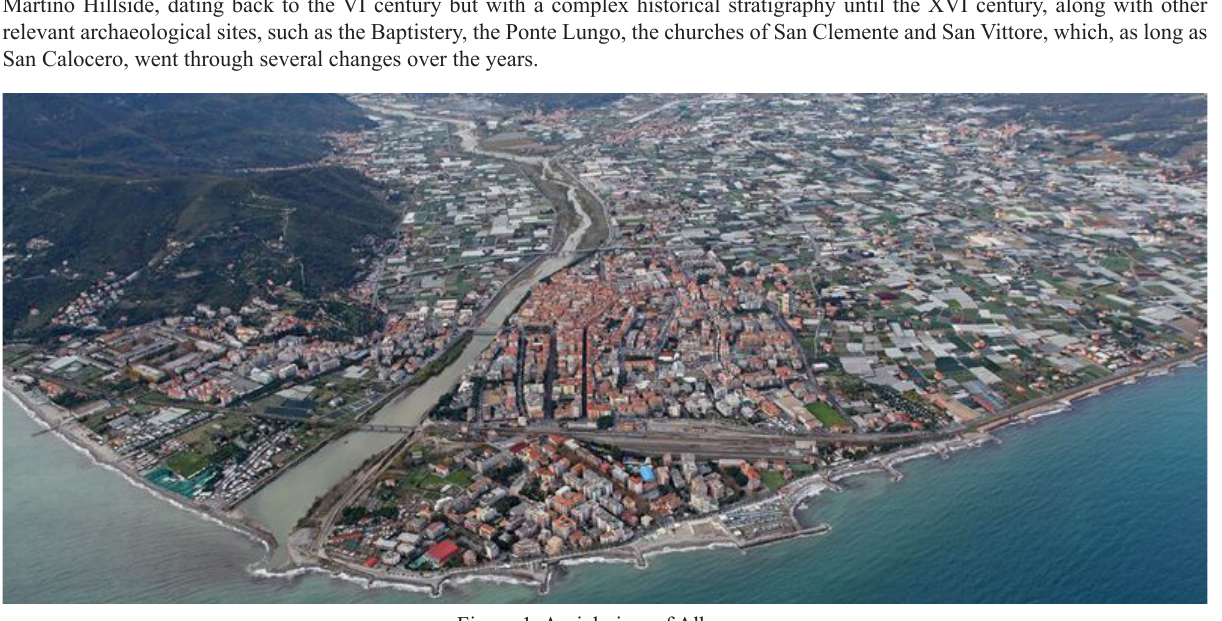
Figure 1. Aerial view of